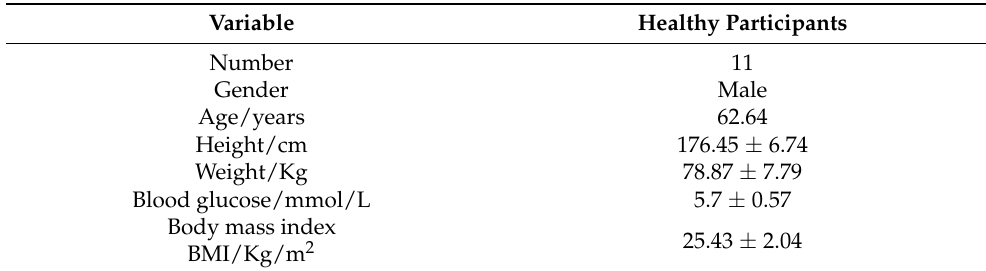
Table 1. Characteristics of the participants in this study. Data indicate means ± SD. Healthy control participants ( n = 11). N. Number.